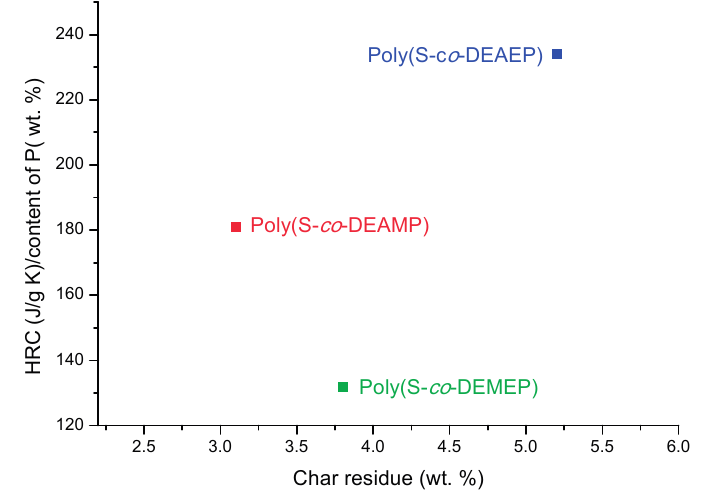
Figure 8. Ratio of HRC to the content of P versus PCFC char residue for the copolymers of